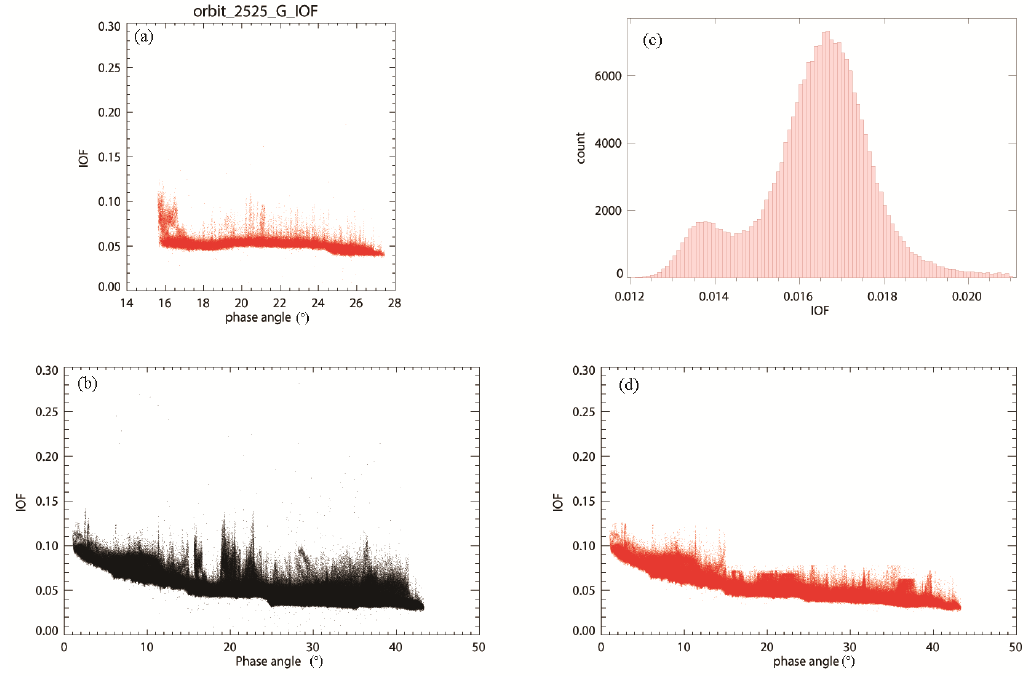
Figure 2. ( a ) Density plot of I / F at orbit 2525; ( b ) The histogram of the I / F of sample data at orbit 2525; ( c ) density plot of I / F; ( d ) density plot of I / F after ‘albedo filtering’. The data and software we used can be found in Supplementary